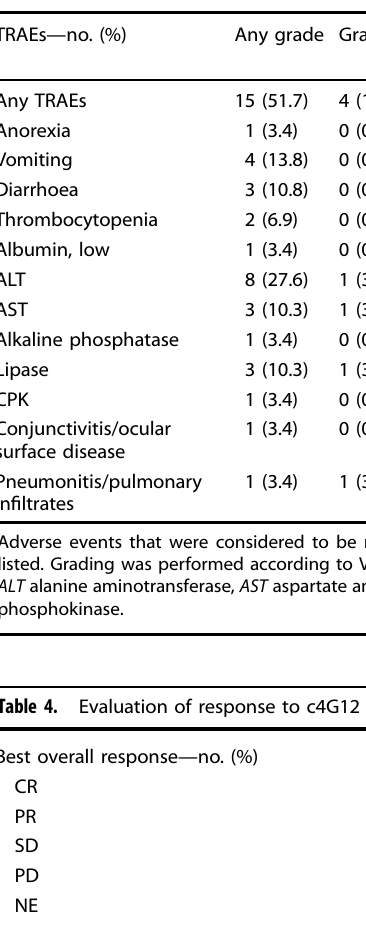
Table 2. Characteristics of the dogs at baseline. Table 3. Treatment-related adverse events (TRAEs).